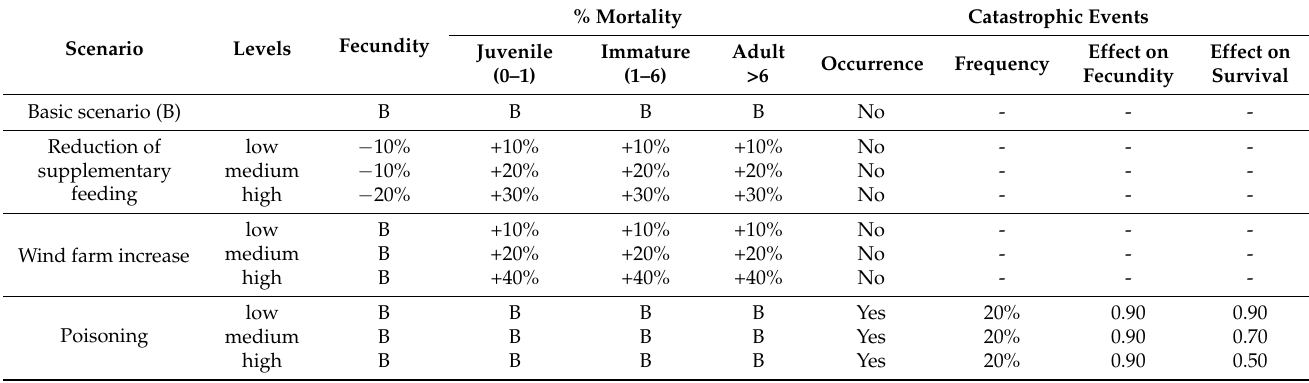
Table 2. Simulated scenarios used in Population Viability Analysis of the Eurasian Black Vulture ( Aegypius monachus ) in Southeast Europe. Parameters of the Basic Scenario (B) are presented in Table 1. The intensity levels for each alternative scenario were chosen in a similar way as provided by Garc í a-Ripoll é s and L ó pez-L ó pez [42] and presented the magnitude of change of the demographic parameters in relation to the Basic scenario. Poisoning inserted as a catastrophic event with frequency of occurrence 20% probability to occur in a year. The effect on fecundity was set at 0.90 (10% decrease) and the effect on survival was set at 0.90 (10% decrease), 0.70 (30% decrease) and 0.50 (50% decrease) for low, medium, and high poisoning,